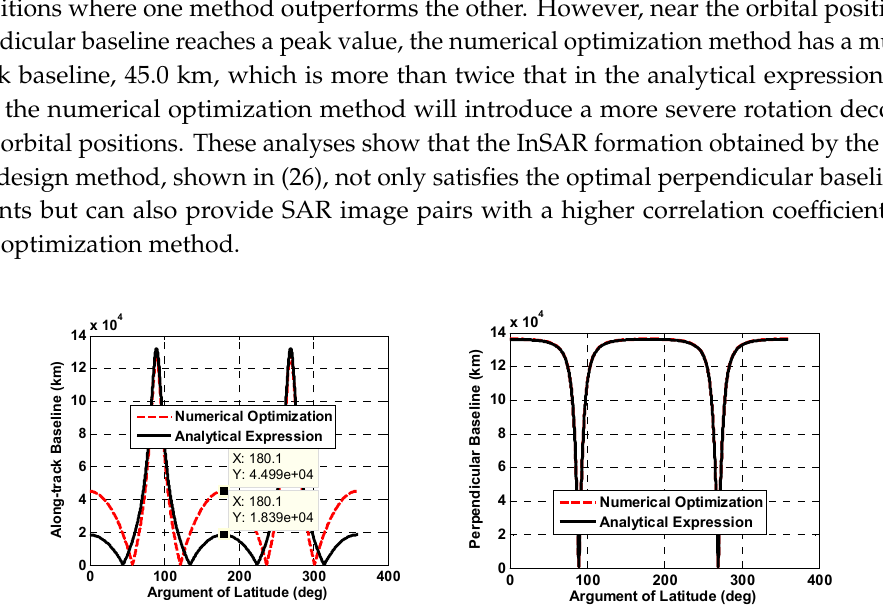
Figure 8. Baseline comparison of numerical optimization and proposed analytical expression for GEO InSAR. ( a ) Along-track baseline; ( b ) Perpendicular baseline.